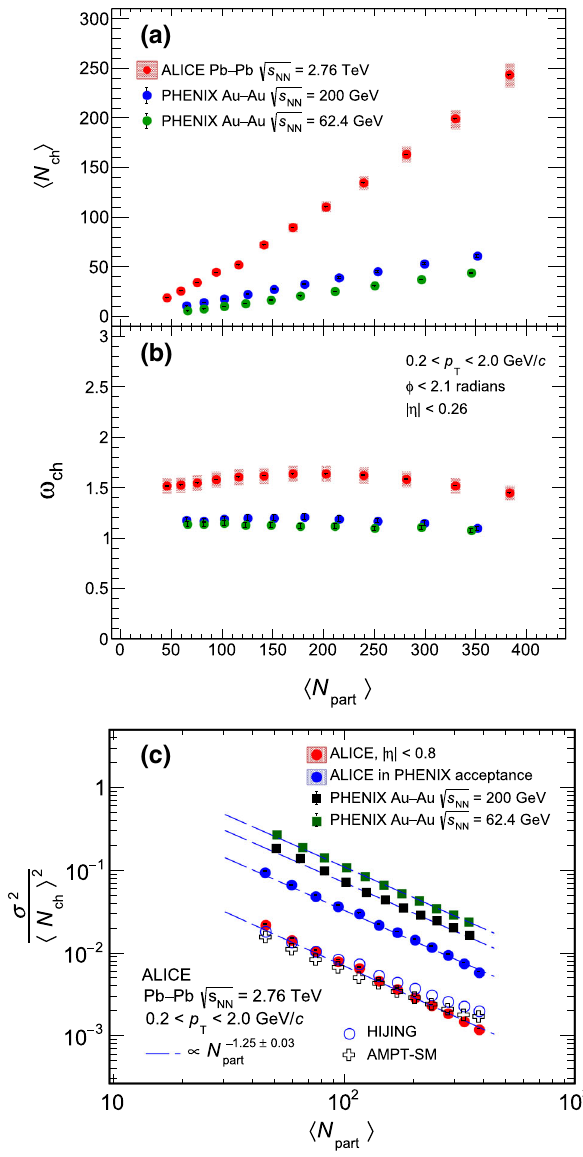
/ (cid:3) N (cid:4) 2 measured in this ch ch